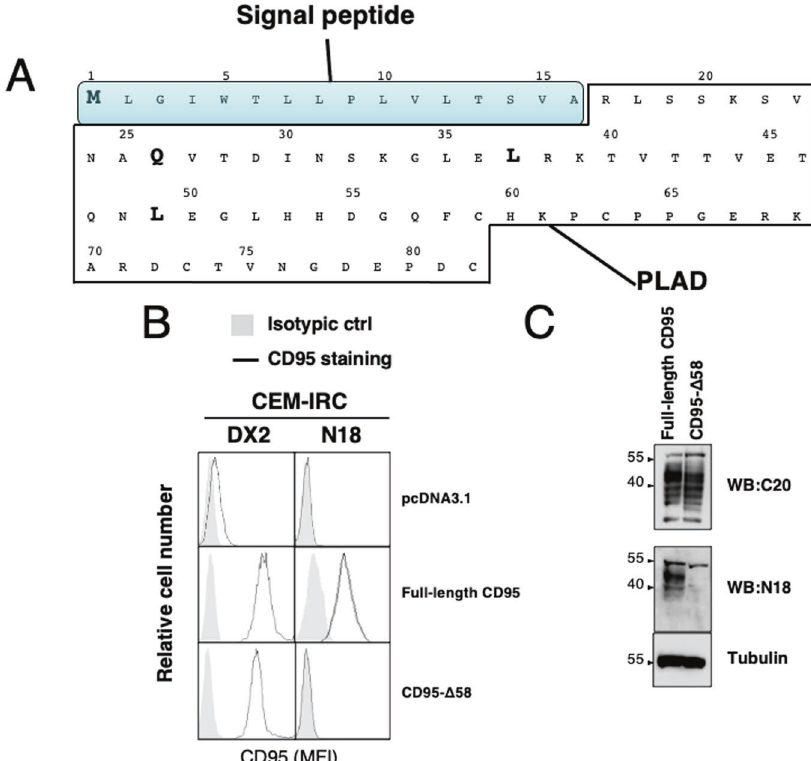
Fig. 1 Loss of the N-terminal region of the CD95 receptor. A Schematic representation of the N-terminal region of CD95 with the signal peptide depicted in blue. The PLAD is indicated. Bold amino acids represent the fi rst putative amino acids of mature CD95 proteins identi fi ed using terminal amine isotopic labeling of substrates (TAILS; http://clipserve.clip.ubc.ca/top fi nd/). B CD95-de fi cient CEM-IRC cells were transfected with the indicated cDNA-encoding vectors. Clones expressing similar expression level of the indicated CD95 constructs